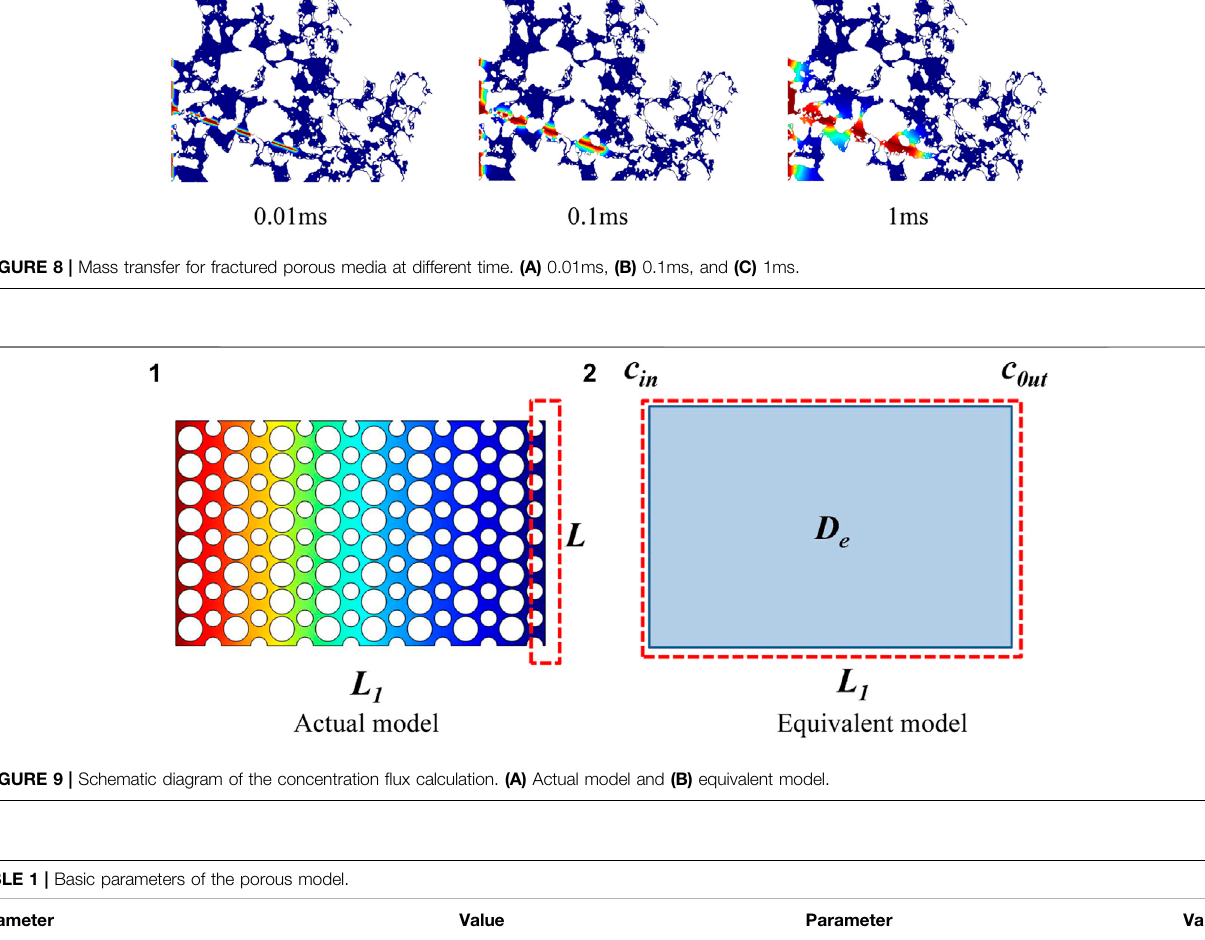
TABLE 1 | Basic parameters of the porous